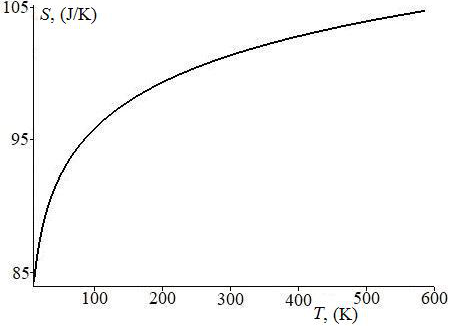
Fig.4. Entropy S of ensemble of kinks of plasmid